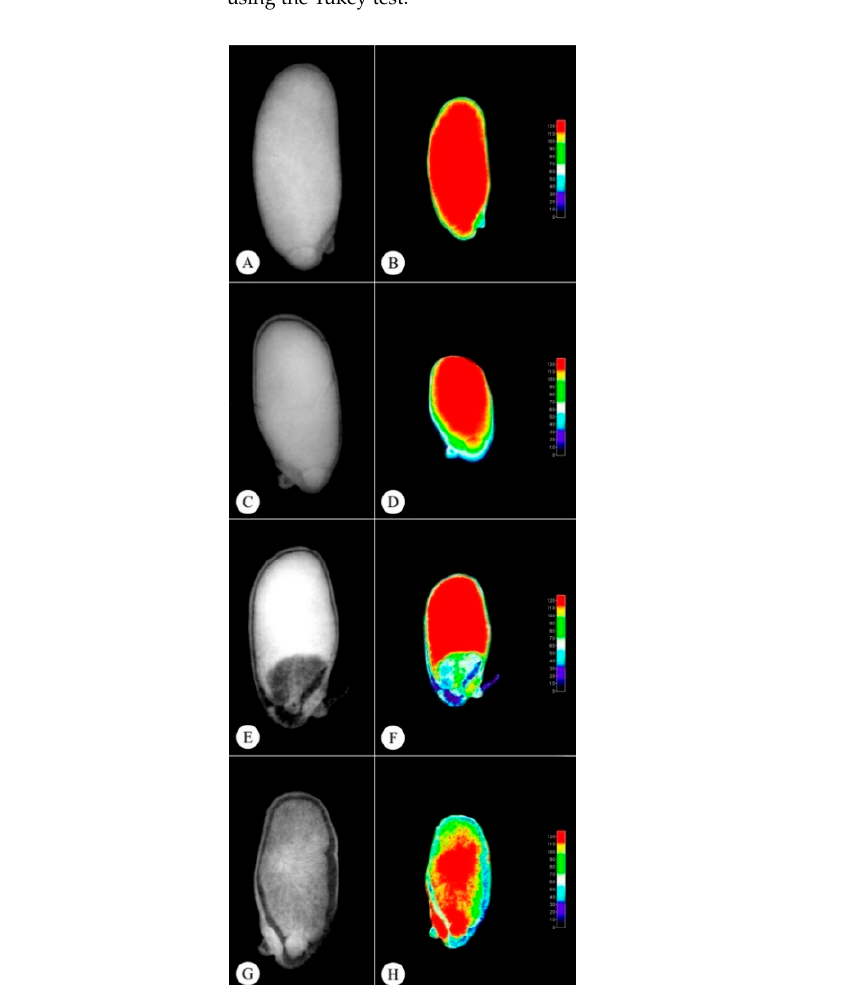
Figure 2. Pterodon pubescens radiographic seed images and 3D ( A , B ) yellow seeds, ( C , D ) light brown seeds, ( E , F ) dark brown seeds and ( G , H ) black seeds.